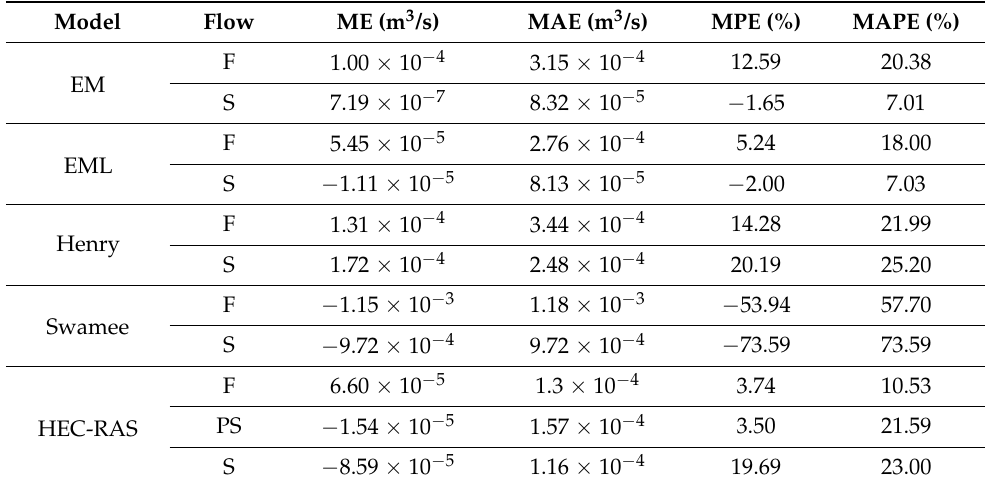
Table 5. Evaluation of models in estimating the flow rate in the full sluice gate operation range.